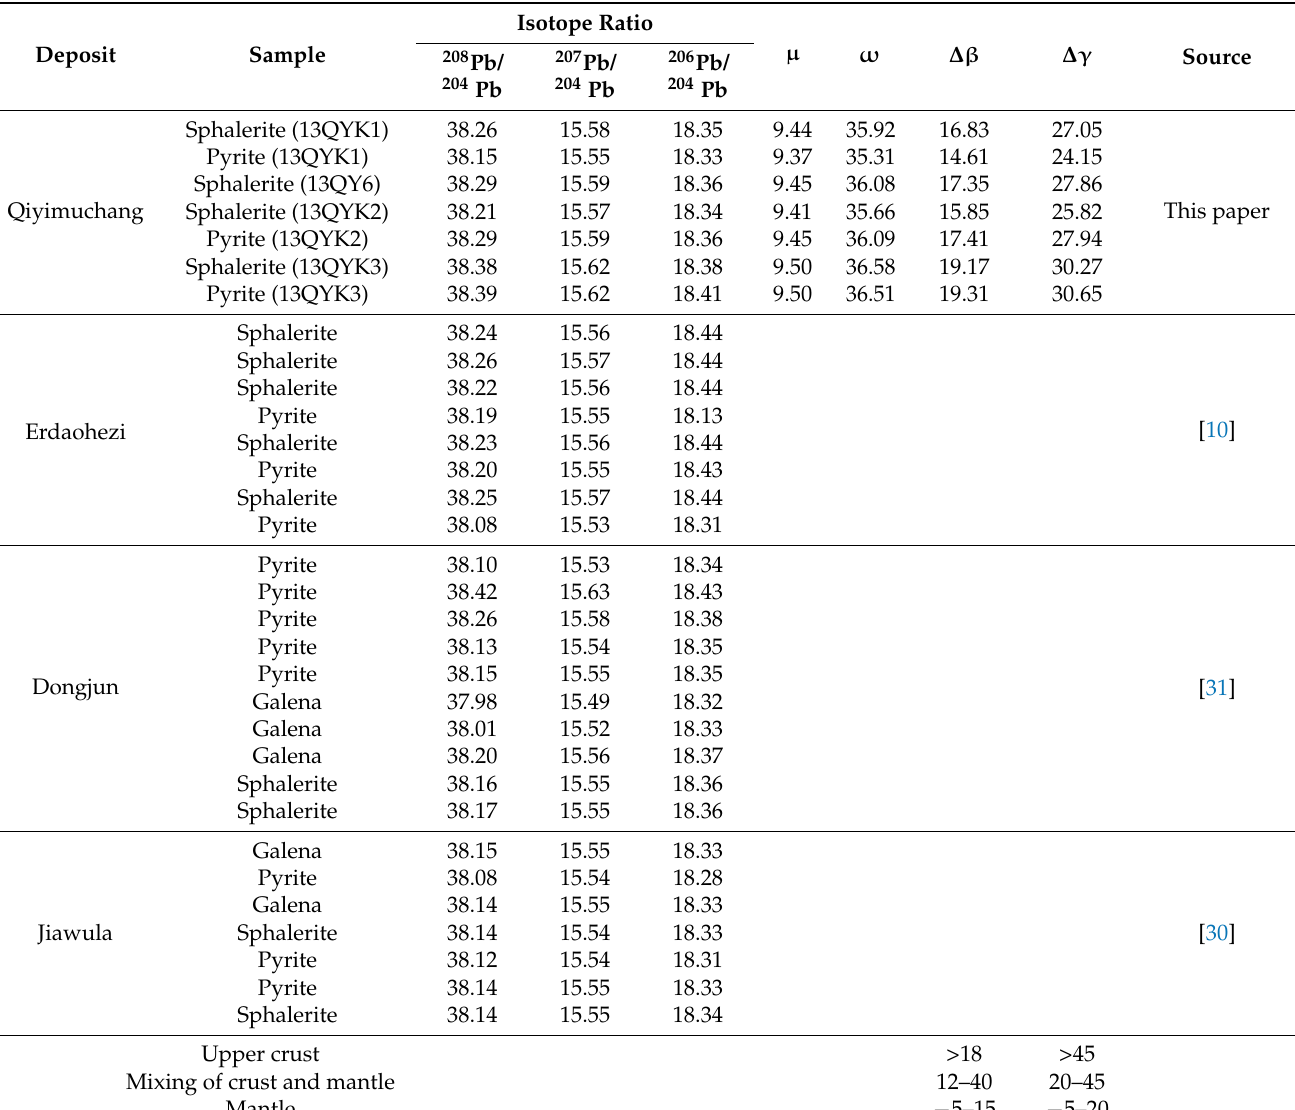
Table 3. Lead isotope data of ore minerals from typical lead–zinc deposits in Erguna metallogenic